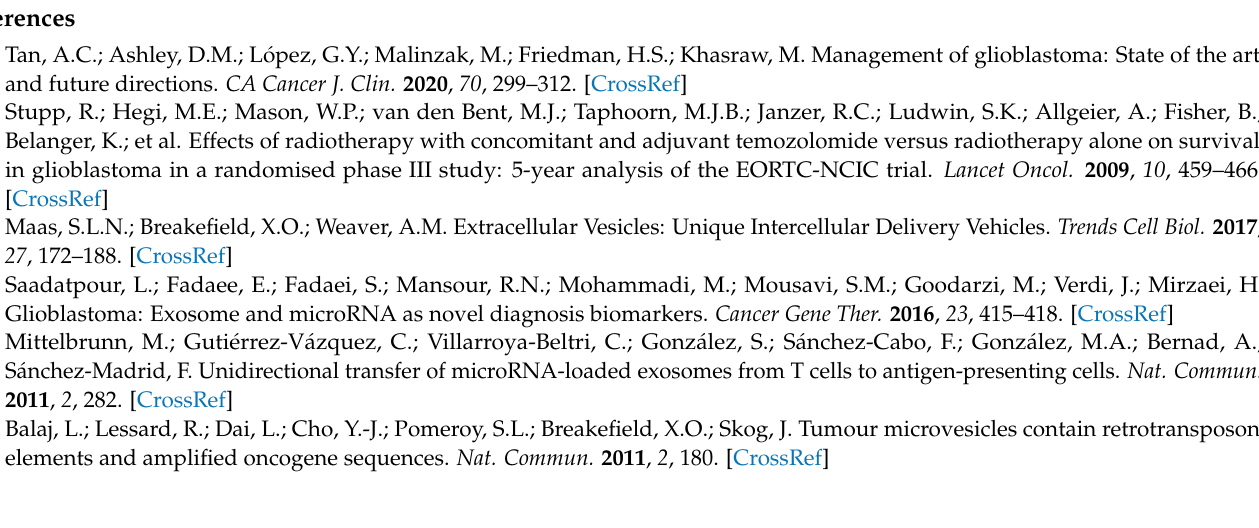
Figure S3: Endogenous transcript levels of the SRPX; Figure S4: SRPX silencing in glioblastoma cell lines and HEK293T cells; Figure S5: Silencing SRPX reduces colony formation in U251-MG-P and U251-MG-R cells; Figure S6: SRPX silencing decreases cell viability of U251-MG-R cells. Table S1: EVs protein expression and their parental cell lines; Table S2: Information related to the patients participated in the study and glioblastoma mutation status; Table S3: Sequences of Oligos; Table S4: Total proteins identified; Table S5: The top 100 proteins frequently identified in